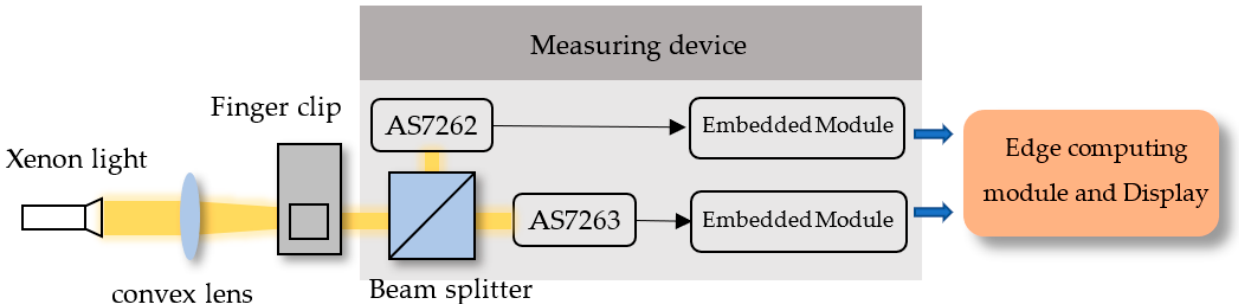
Figure 3. Design and assembly of 3D printed sensor light sensing case ( a ) top ( b ) back.